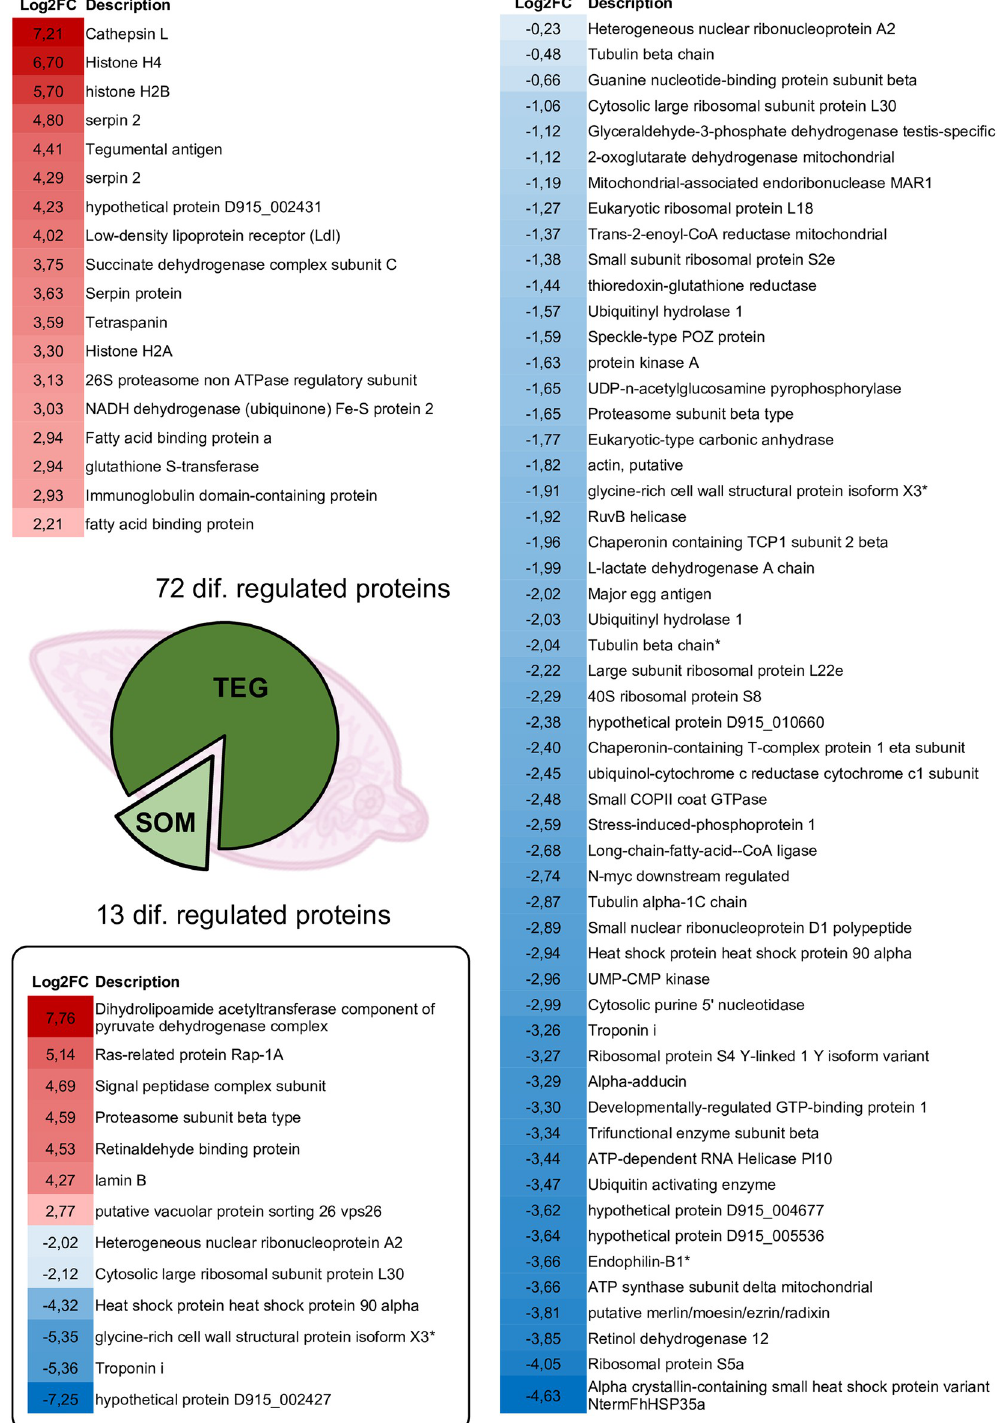
Fig 5. Upregulated (in red) and downregulated (in blue) proteins in tegument (upper panels) and somatic (box lower panel) extracts of F . hepatica juveniles after intestinal passage, compared with control FhNEJ. Both protein description and the respective Log2FC values are shown. Colour scales represent the relative Log2FC value in each panel.